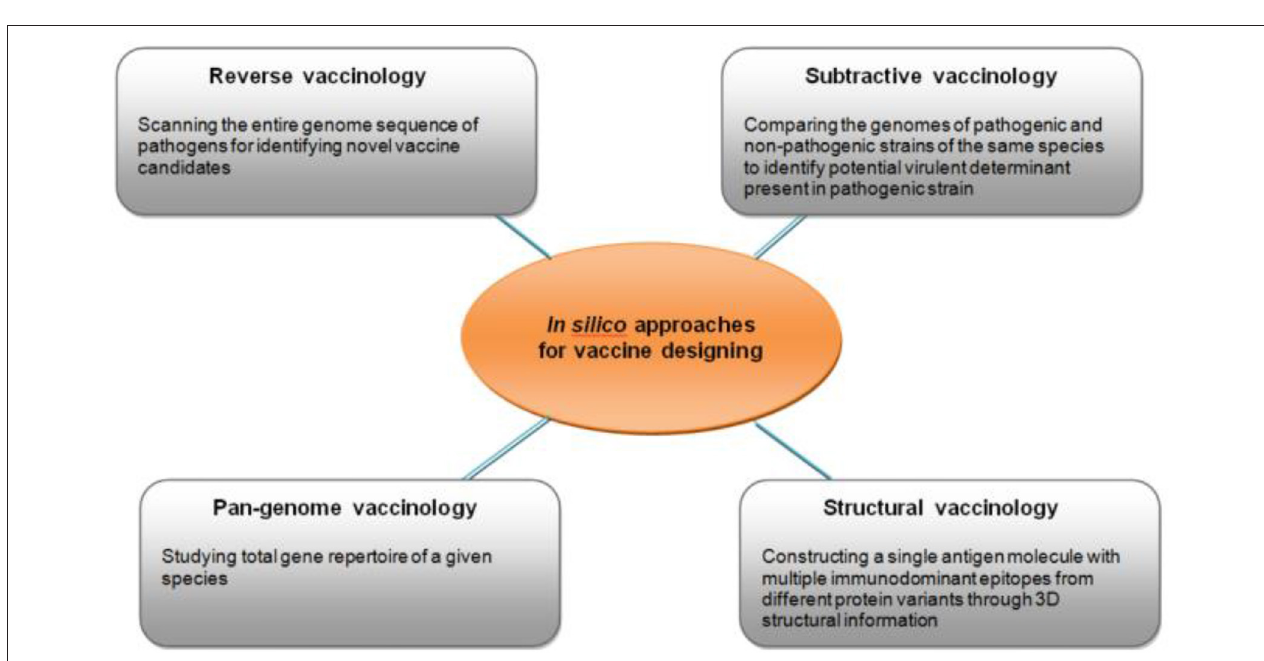
FIGURE 8 | Different types of in silico approaches for identifying potential targets for vaccine development